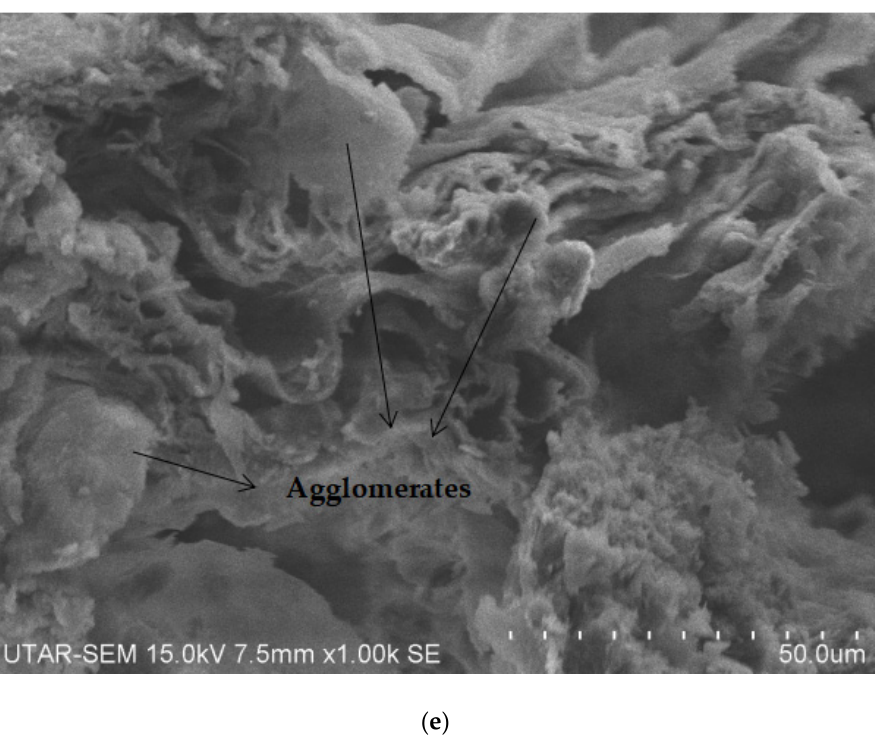
Figure 15. SEM Image of Nylon 610 Nanocomposites Added with Treated Graphite Flakes at 150 °C with ( a ) 0.5 wt%, ( b ) 1.5 wt%, ( c ) 2.5 wt%, ( d ) 3.5 wt%, ( e ) 4.5 wt% at × 1000 magnification.